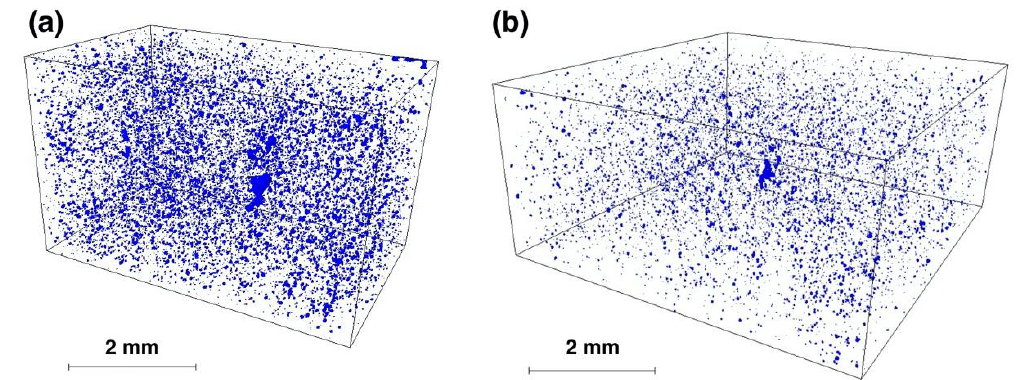
Figure 7. Computer tomographic reconstruction of the porosity volume in the samples produced from ( a ) MAPS powder (sample 2_800) and ( b ) GA powder (sample 5_800).